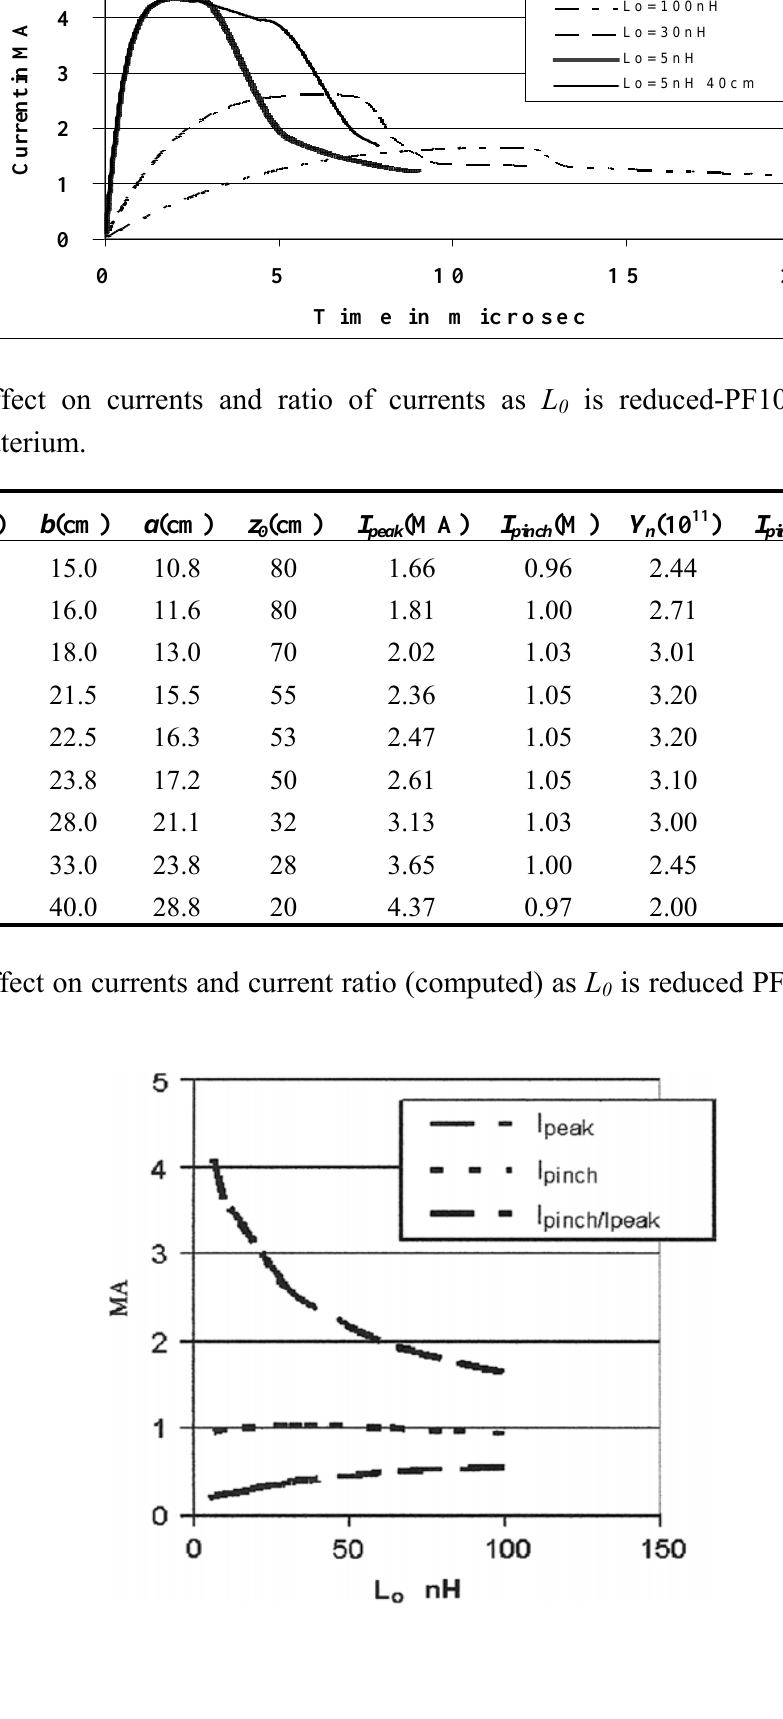
Figure 6. PF1000 current waveforms computed at 35 kV, 3.5 Torr D showing the changes in waveforms as L